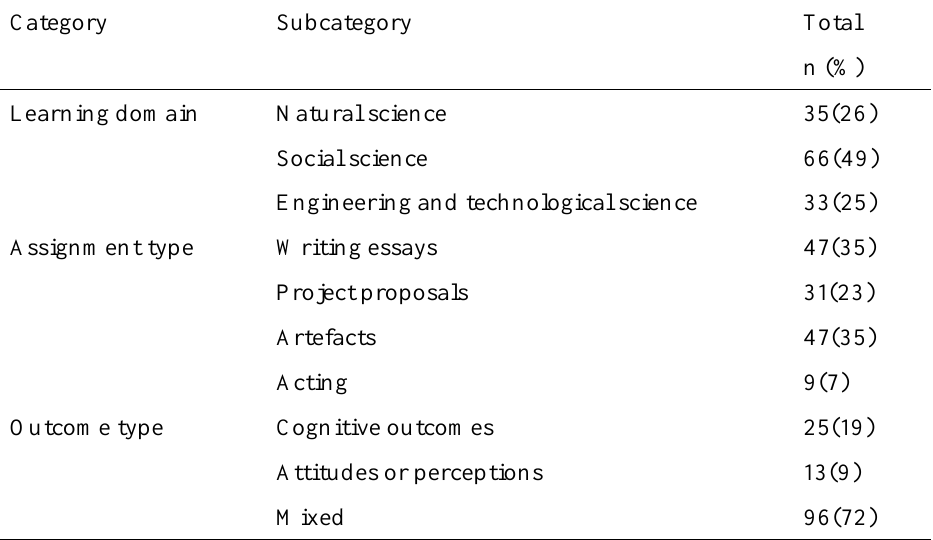
Table 6 Descriptive Data for the Learning